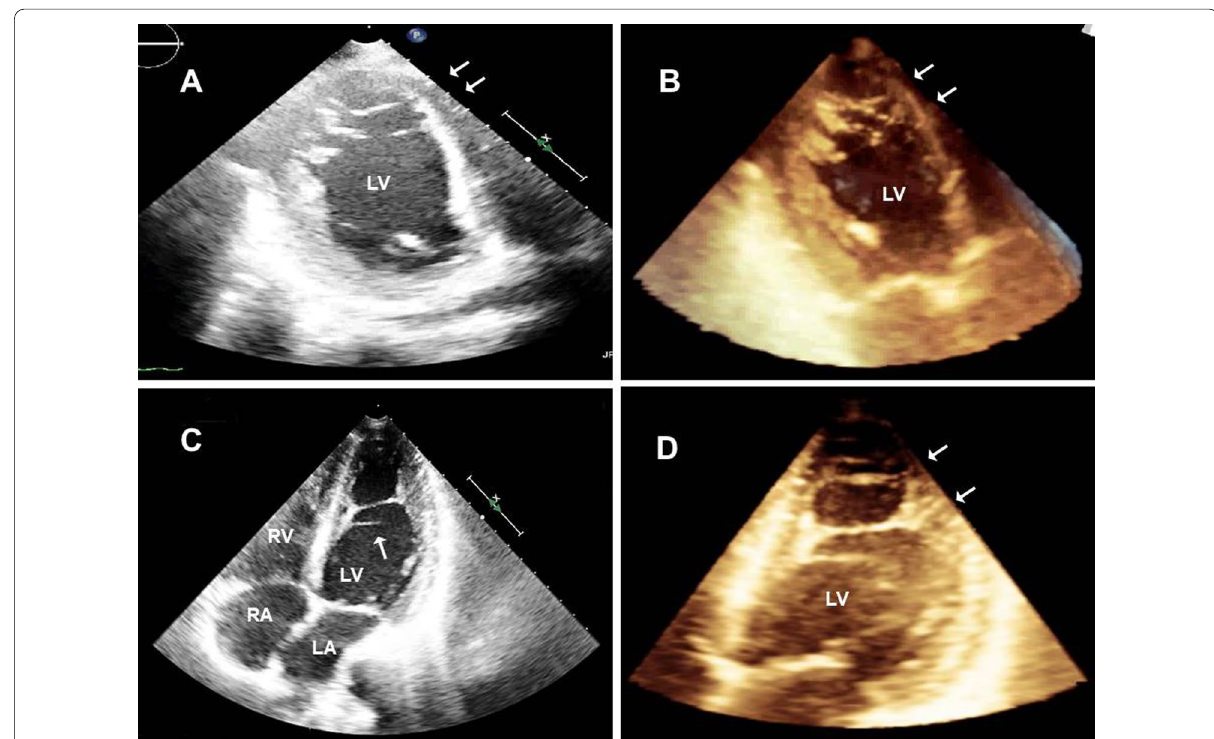
Fig. 3 A , C . Modified two-dimensional echocardiographic examination of two patients shows only two left ventricular false tendons (arrows). However, B , D three-dimensional examination of the same images reveals multiple, mesh-shaped, complex left ventricular false tendon structures